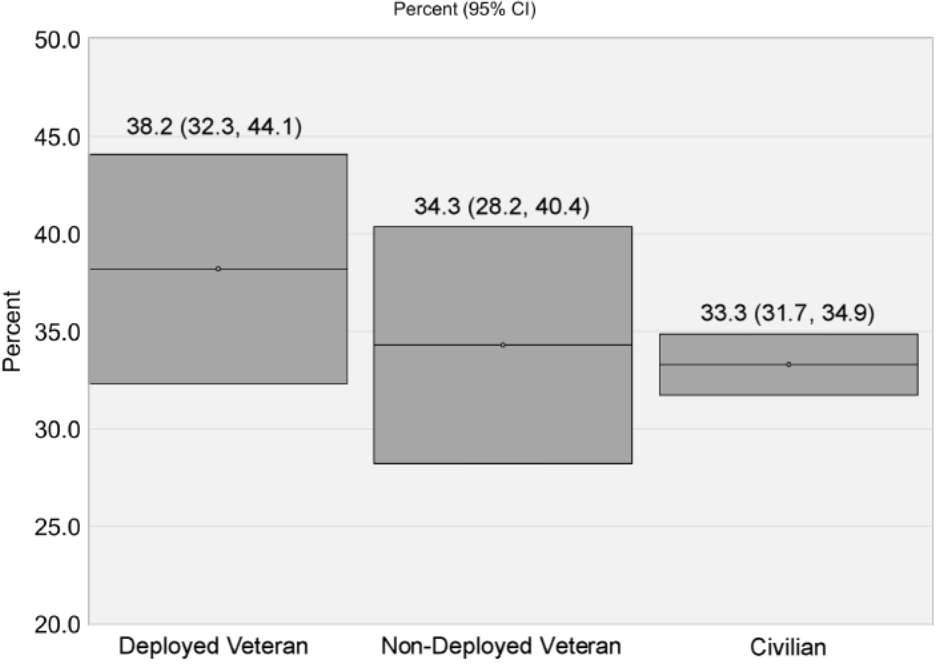
Figure 1. Unadjusted prevalence of clinically elevated high sensitivity C-reactive protein (hs-CRP) levels among veteran status and civilians (10,736). Presented as percentage prevalence and 95% confidence intervals (LCL-UCL). LCL, lower confidence limits; UCL, upper confidence limits .